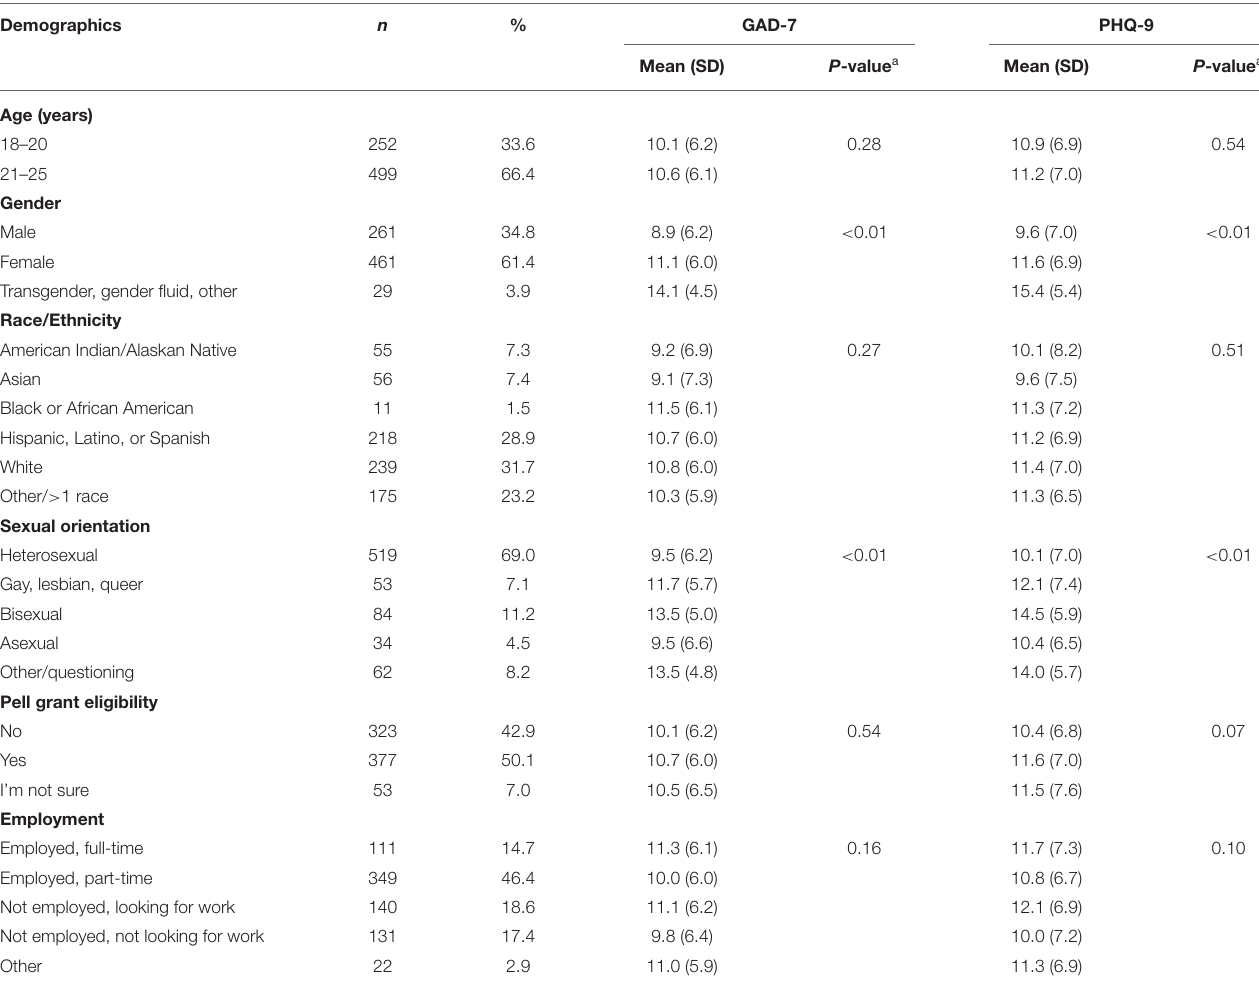
TABLE 1 | Demographic characteristics of study participants and raw GAD-7 and PHQ-9 scores.